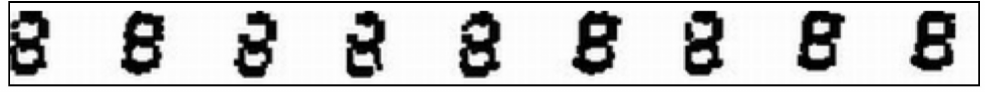
Figure 7. Di ff erent morphologies representing the character 8. Figure 7. Different morphologies representing the character 8.